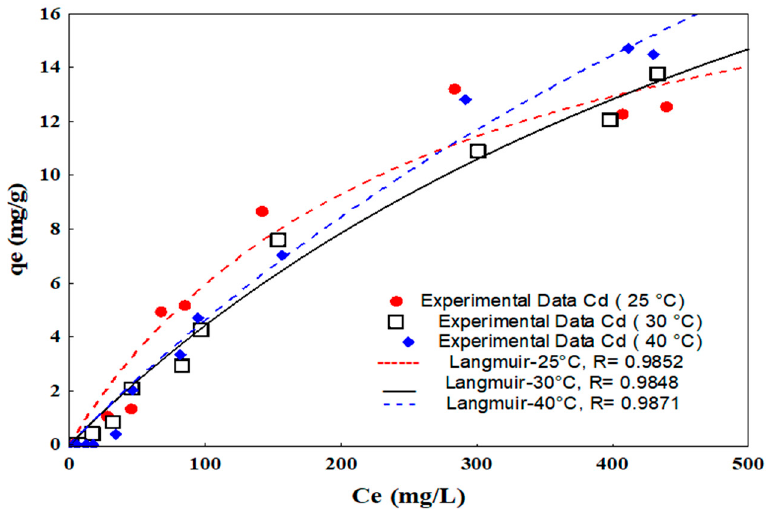
Figure 10. Cd adsorption isotherms onto FeNP/NFC composite at 25, 30, and 40 °C. Table 3. Parameters of kinetic models for Cd and Pb adsorption onto FeNP/NFC.